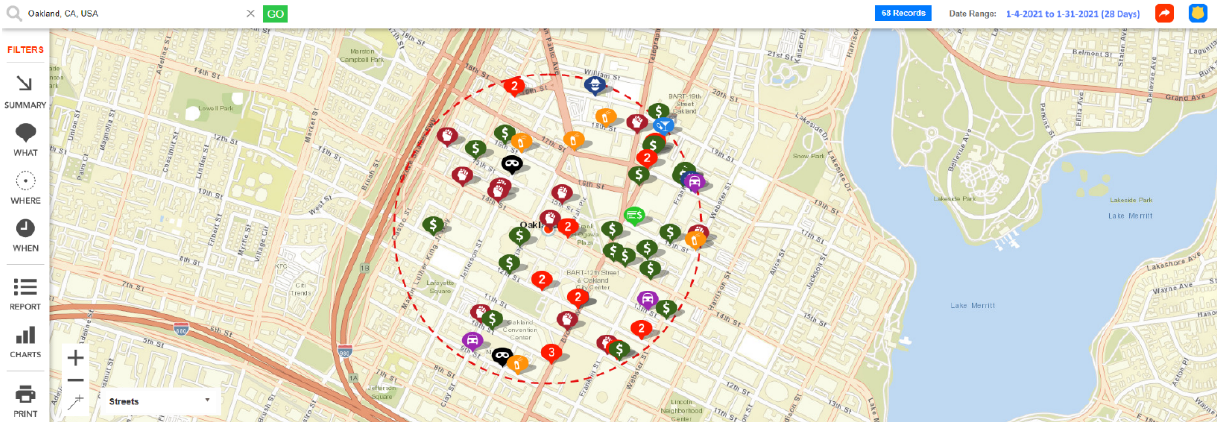
Figure 10. Showing specific incidents in Oakland, California from 01/04/2021 to 01/31/2021